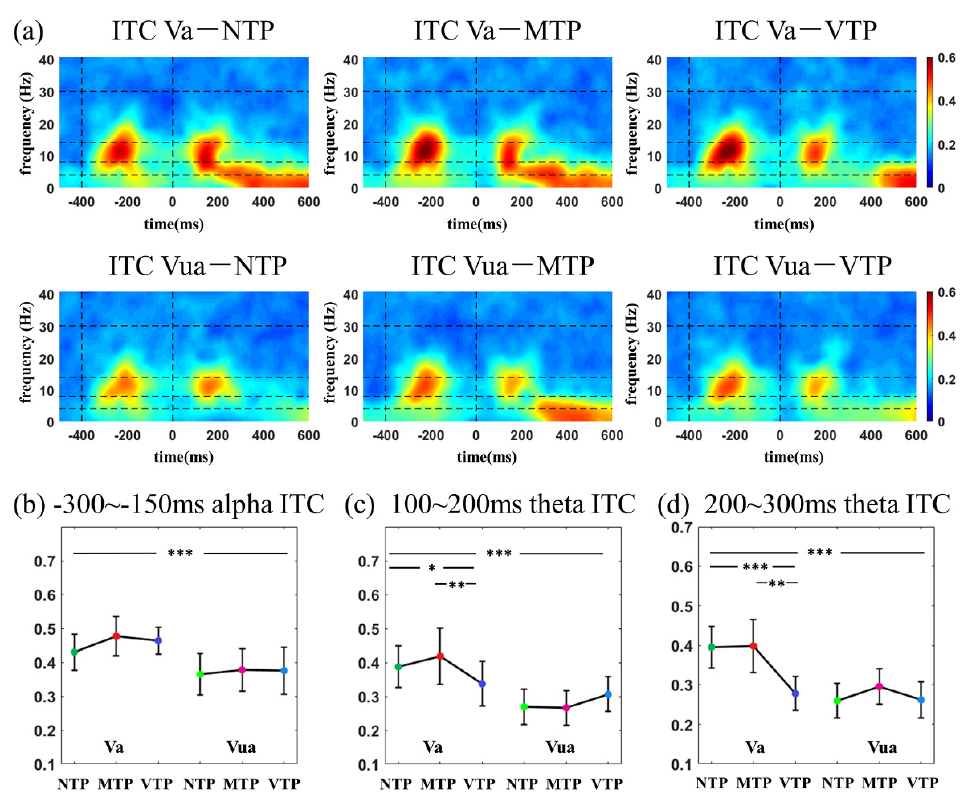
Figure 5. ( a ) ITC time − frequency distributions in visual modality; comparisons among distinct MA ‐ TP conditions of ( b ) − 300– − 150 ms alpha ITC; ( c ) 100–200 ms theta ITC; ( d ) 200–300 ms theta ITC. Statistical significance: the asterisks at the top of each figure indicated the MA main effect; the as ‐ terisks above the Va condition (Va − NTP, Va − MTP, Va − NTP) indicated the TP simple effect under attended condition, when the MA − PT interactive effect existed. * 0.1 < p < 0.5; ** 0.01 < p < 0.1 *** p < 0.001.